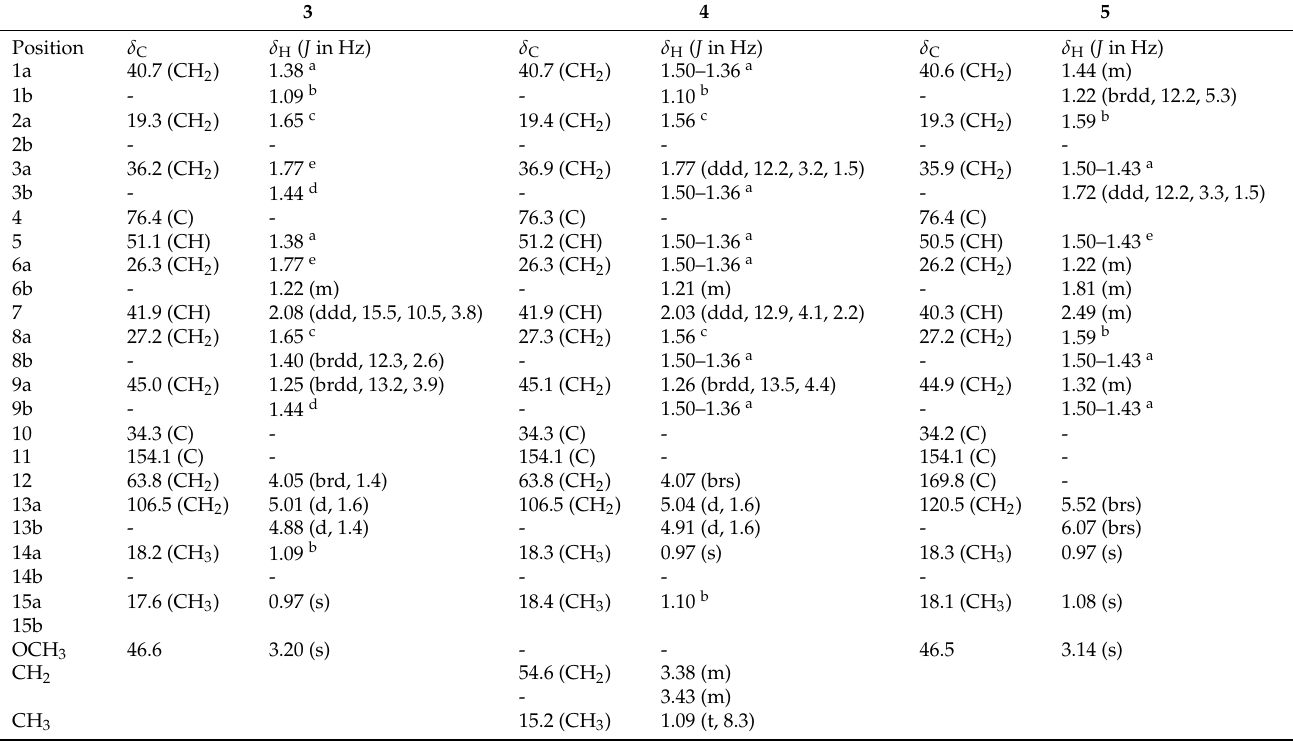
Table 2. 1 H and 13 C NMR data for Compounds 3 – 5 (MeOH- d 4 , 600 MHz, J in Hz).